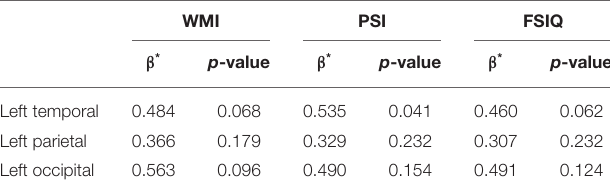
TABLE 3 | Association between Regional CBF and WISC-IV